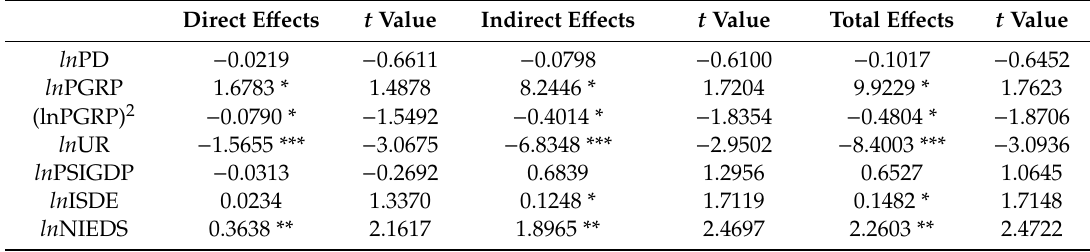
Table 6. Decomposed spatial e ff ects of SPDM with two-way